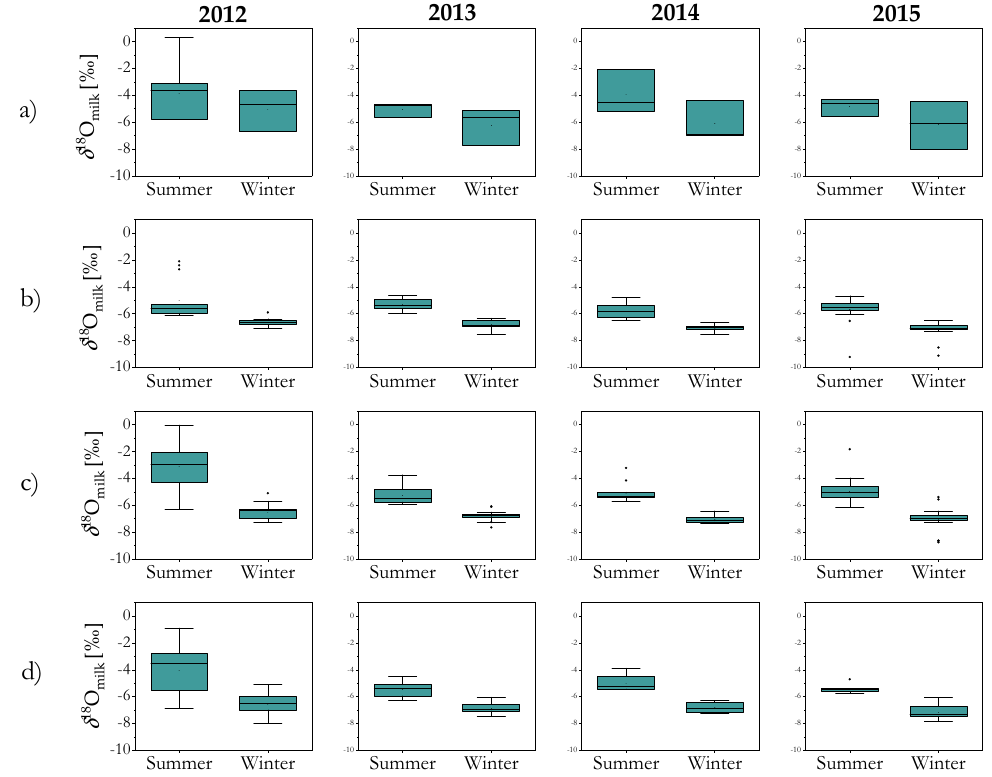
Figure 1. Box plots of the δ 18 O milk values in cow milk collected from four macro-regions in Slovenia: ( a ) the Mediterranean, ( b ) Pannonian, ( c ) Alpine, ( d ) Dinaric region during summer and winter in 2012–2015.